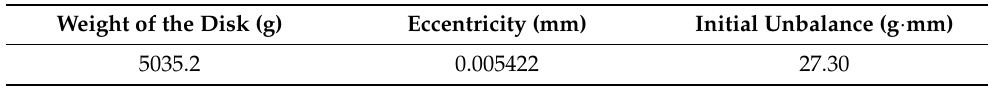
Figure 10. Least-squares circle fitting. Table 3. Data of the disk.